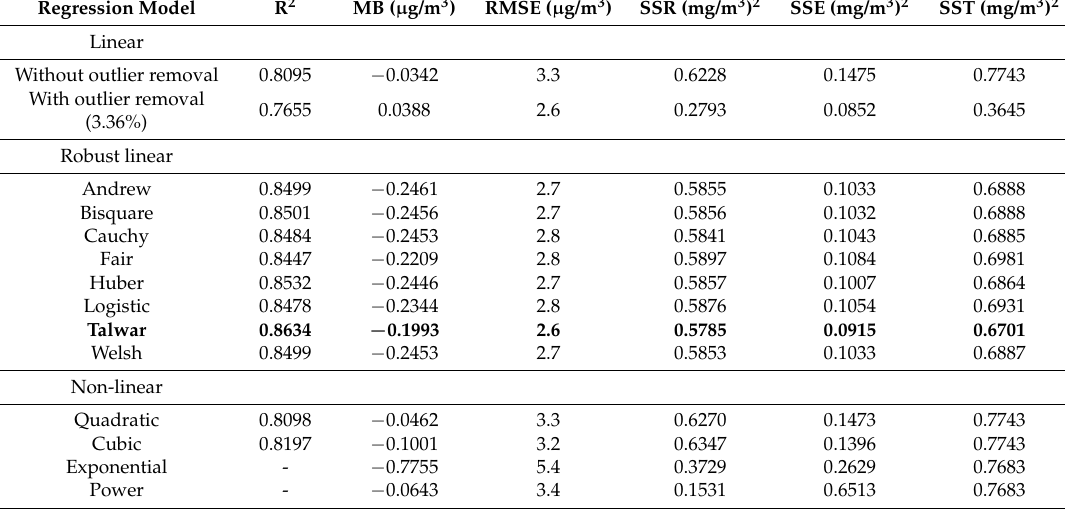
Table 2. Statistical scores of PM 2.5 sensor laboratory calibration (N =